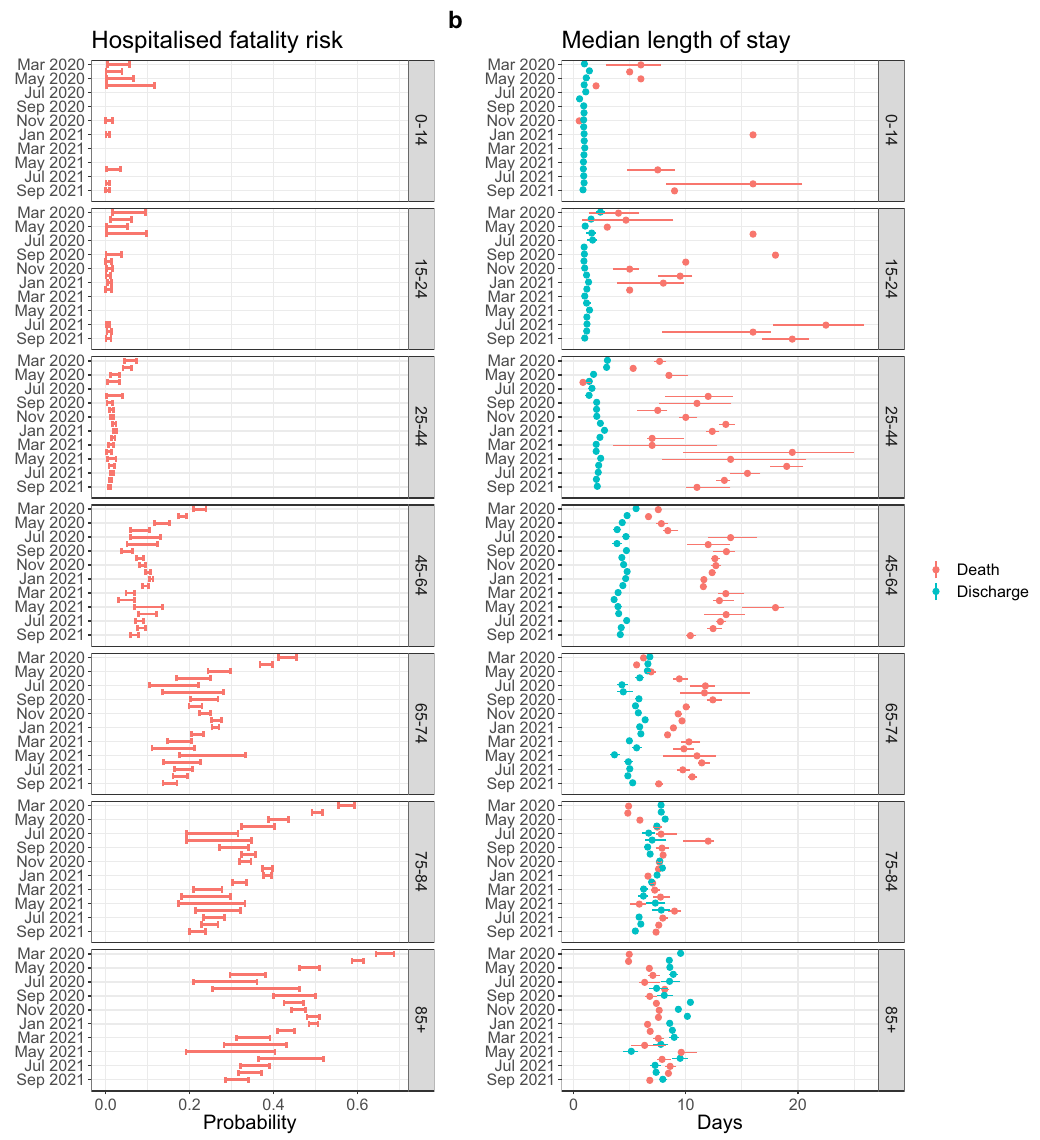
Figures in brackets represent 95%con fi dence intervals. Estimatesarereplacedwitha dash ( – ) where insuf fi cient information was available.